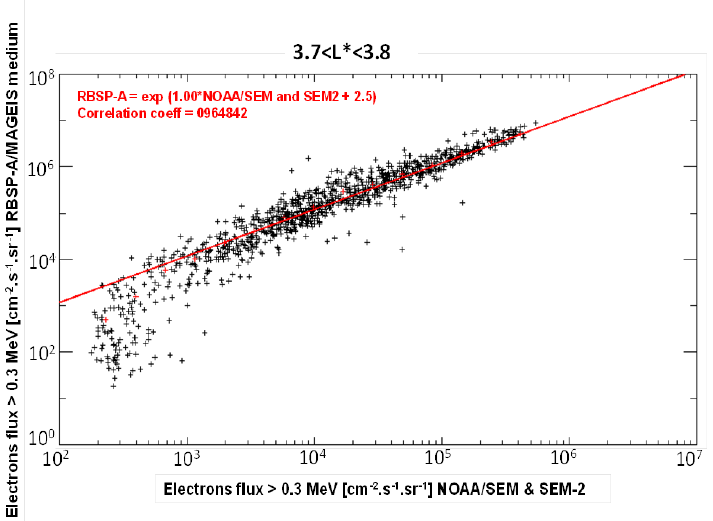
Figure 4. Example of correlation between NOAA-POES and Van Allen Probe-A flux for electrons >0.3MeV and for L ∗ between 3.7 and